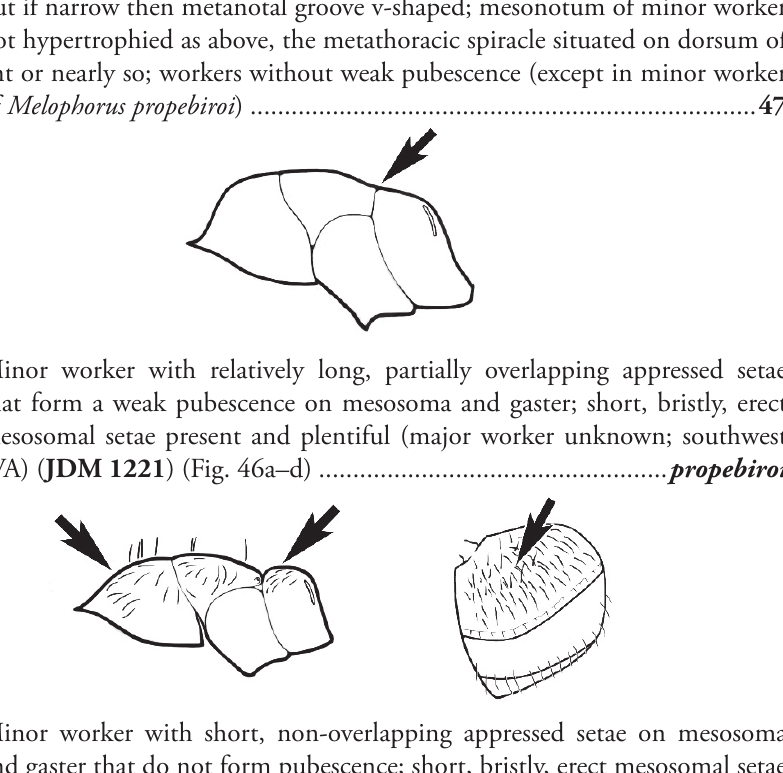
sparse or absent in minor worker ..............................................................